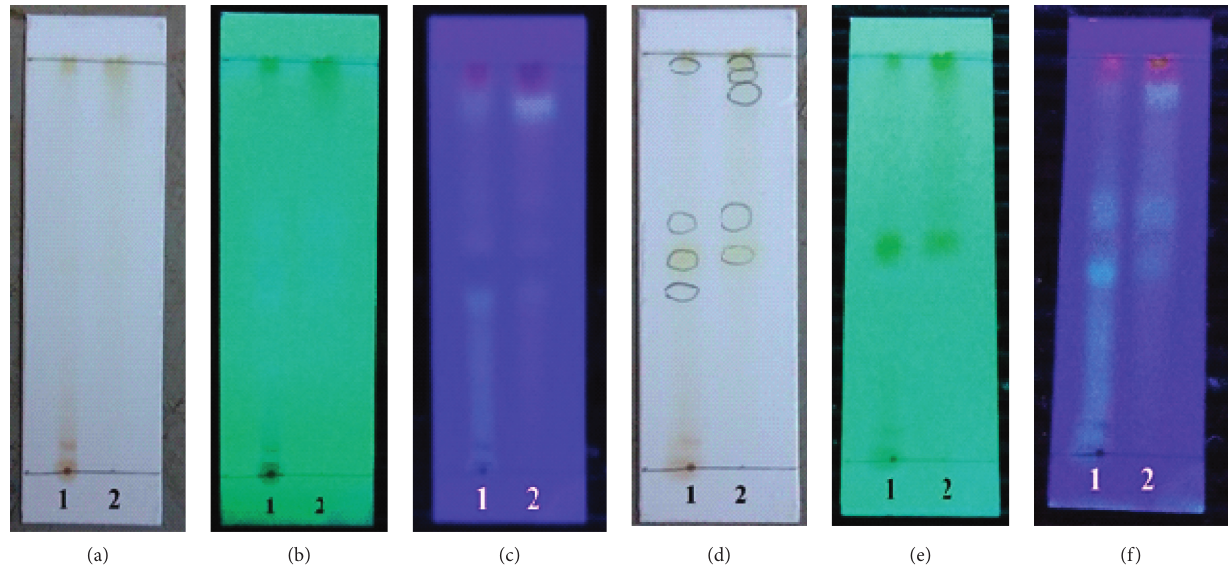
Figure 1: TLC profile of ethanol extract and ethyl acetate fraction of cassava leaves with the developer of n-butanol :acetic acid: water (4:1: 5). (a) Visible light, (b) under UV 254nm, (c) under UV 366 nm, (d) visible light +addition of AlCl 3 , (e) under UV 254nm +addition of AlCl 3 , and (f) under UV 366nm+addition of AlCl 3 . 1 indicates ethanol extract, and 2 indicates ethyl acetate